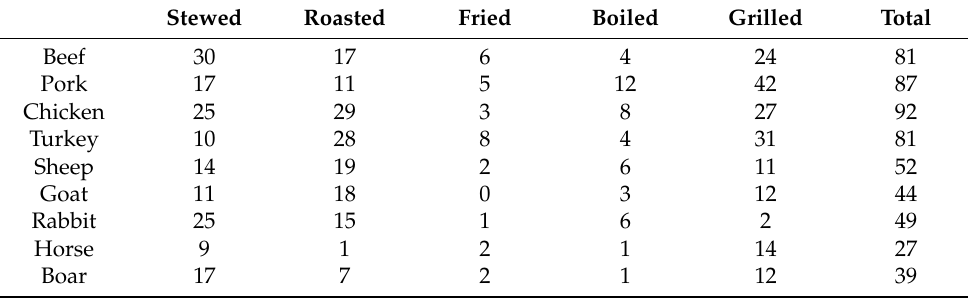
Table 3. Cooking methods used for